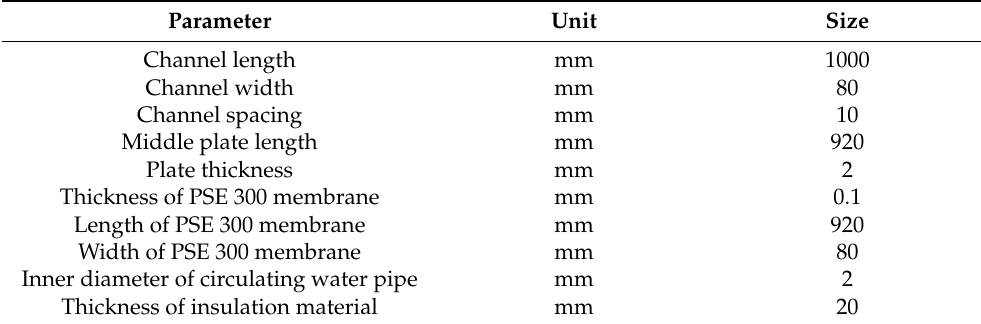
Table 1. Geometric size for the membrane-based dew-point evaporative cooling system.